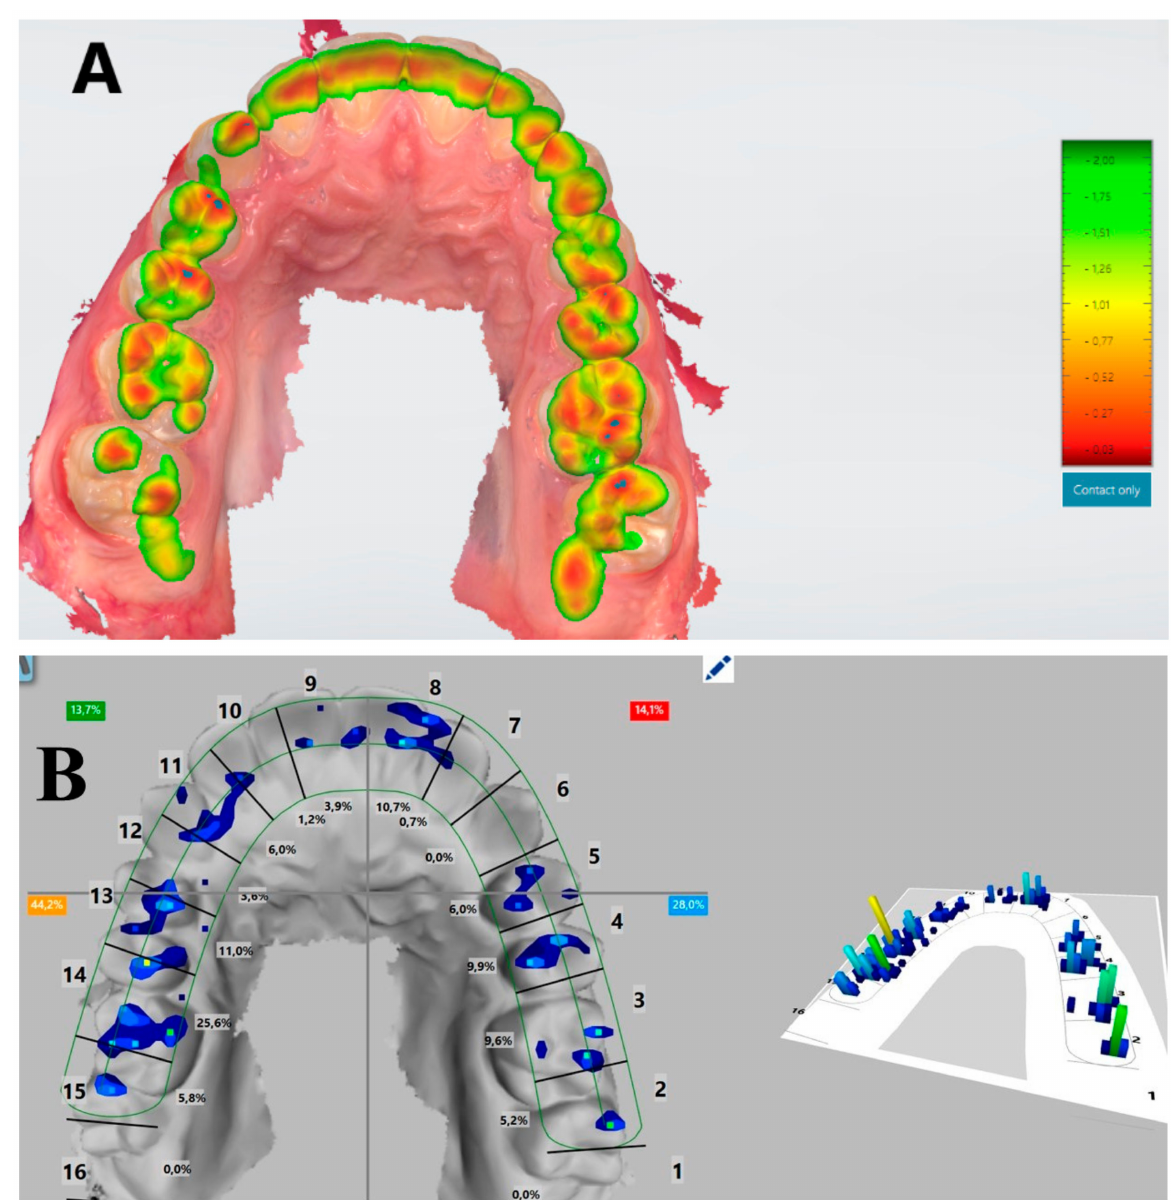
Figure 2. ( A ) Occlusion map from intraoral scanner Trios (3Shape, 2014); ( B ) occlusion map from T-Scan Novus (Tekscan,